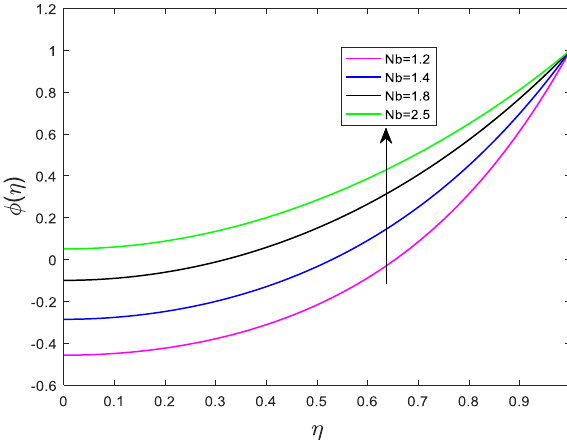
Figure 19: Effect of N t on ϕ ( η ) for fixed S = Ha = N b = 0.5, β = Ω T = Ω C = 0.1, Ec = 0.1, Pr = 0.7, Kr = 2.0 and Sc = 2.0